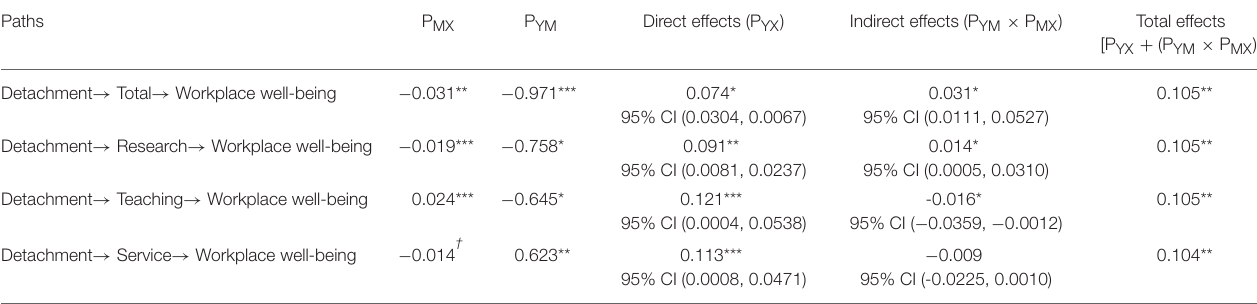
TABLE 7 | Path analysis: indirect and total effects of psychological detachment via total, research, teaching, and service time allocations on workplace well-being. Paths P MX P